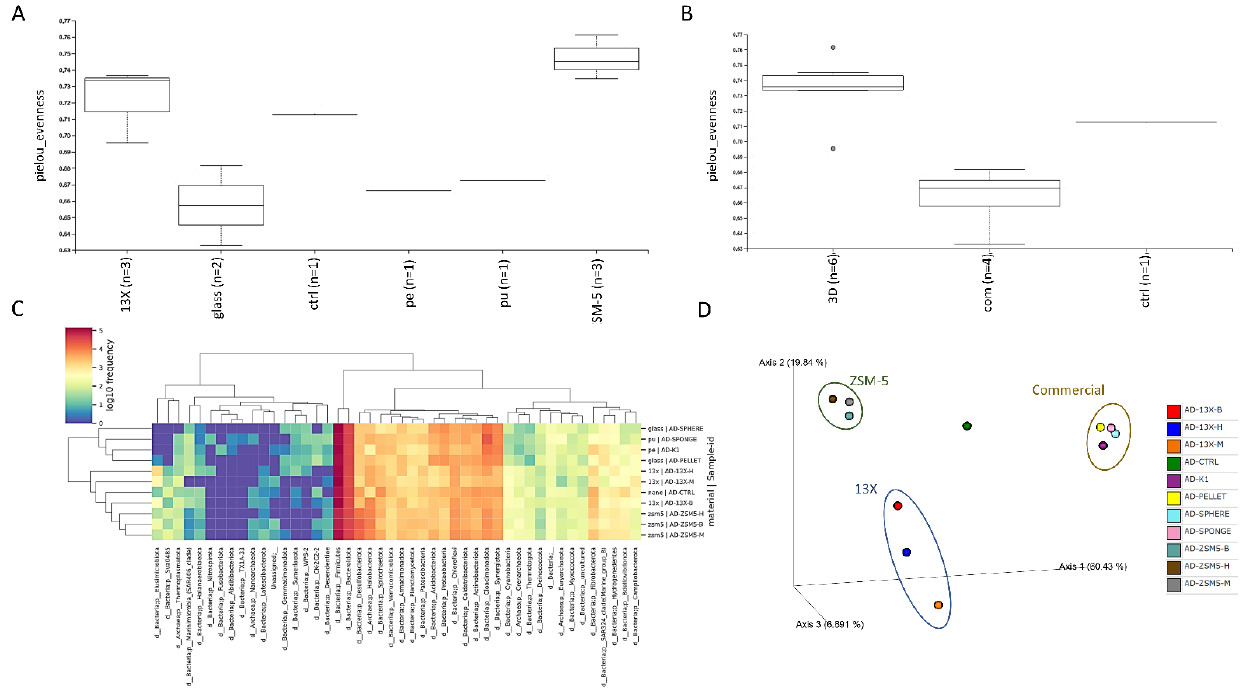
Figure 9. Core metrics results of bioinformatics of AD samples. ( A ). Alpha diversity boxplot of different material groups using the metric pielou-eveness. ( B ). Alpha diversity boxplot of different source groups using the metric pielou-eveness. ( C ). Heatmap of phyla. ( D ). Beta diversity plot using the metric Bray-Curtis. Table 3. Number and percentages of ASVs assigned to bacteria and archaea